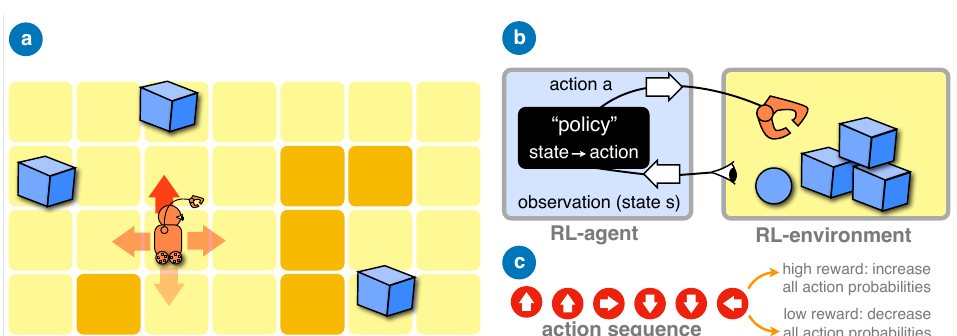
Figure 3: Reinforcement learning. (a) A robot roaming around a grid world and trying to pick up boxes is one simple example of a reinforcement learning